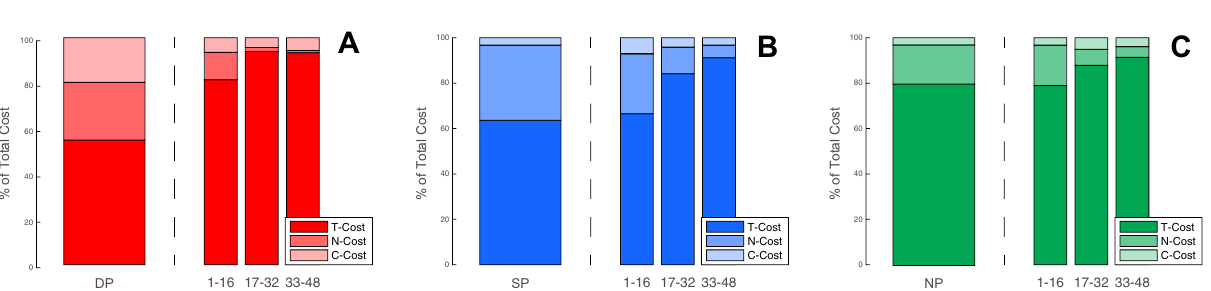
Figure 8. TNC-cost relative weight. The bar plot represents the relative weight of each of the cost components for each group. It is possible to see that for the overall performance, the weight of Noise is very large for the SP group ( B , left side) and Covariance is negligible, whereas for the DP group ( A , left side) both noise and covariance has a relatively equal weight. When investigating the segmented performances, it is possible to see that throughout the performance for the DP group ( A , right side) noise reduces very quickly, accounting for small weight already in the middle of the performance, whereas for the SP ( B , right side) it tends to reduce more gradually. It is also possible to note that the relative weight of tolerance was very high for the NP group for the overall performance ( C , left side) as well as throughout the performance ( C , right